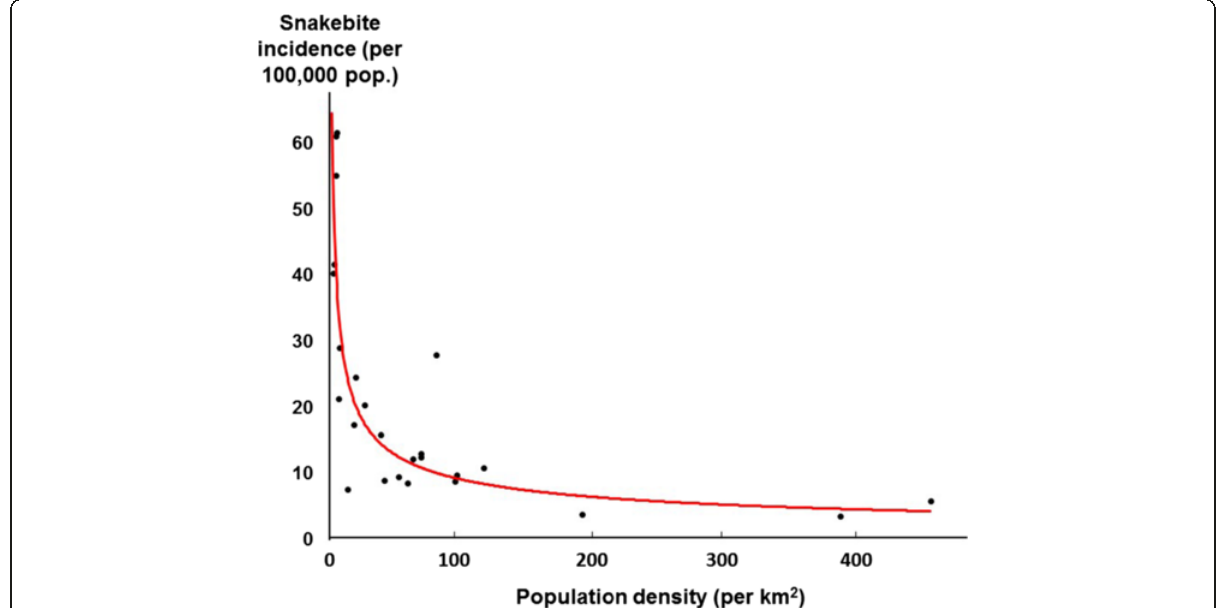
Fig. 12 Relationship between snakebite incidence and human population density